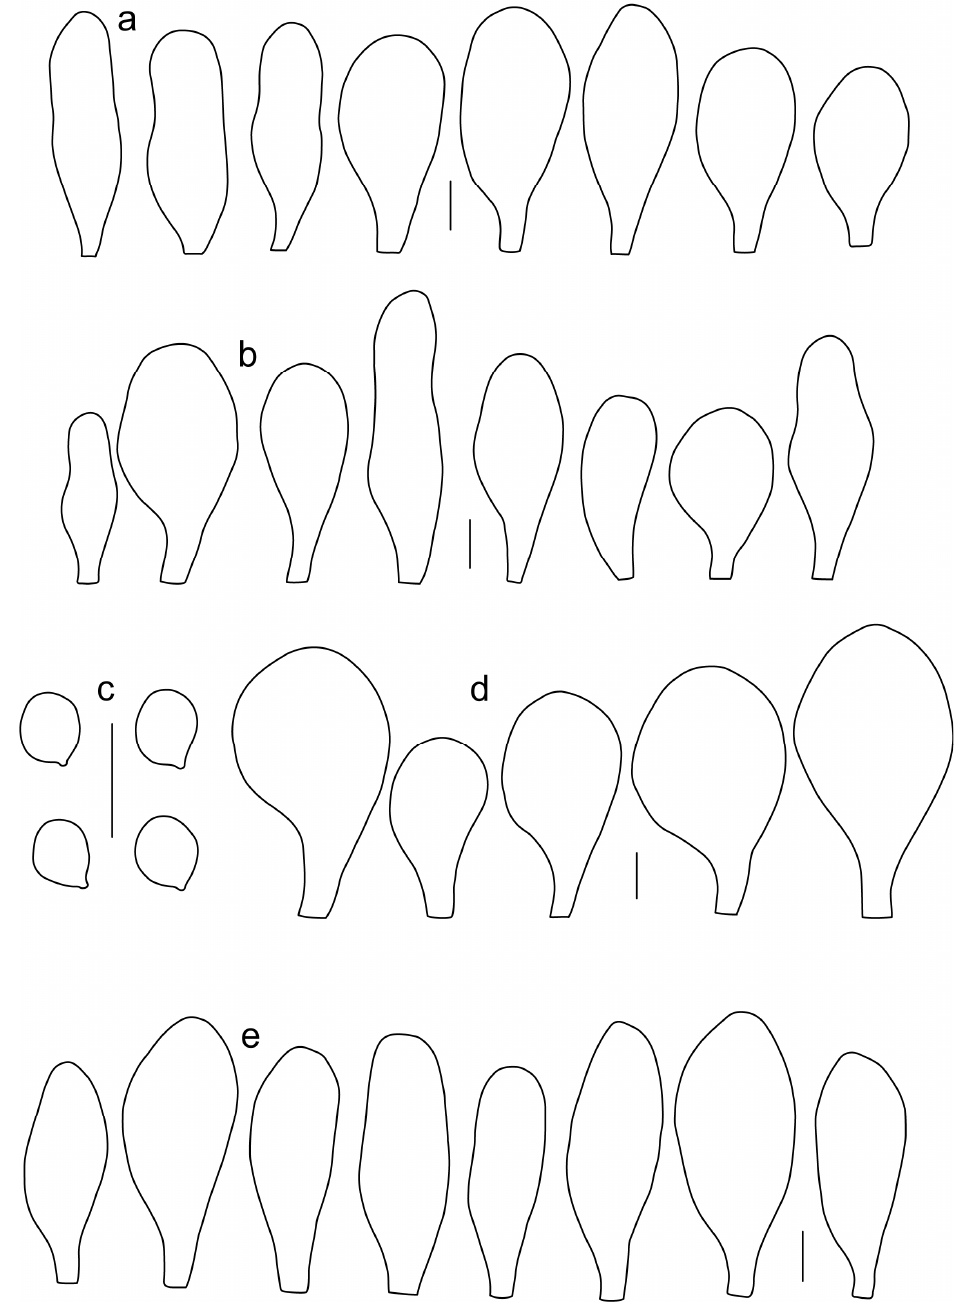
Figure 15. Pluteus vellingae : ( a ). pleurocystidia, ( b ). cheilocystidia ( c ). basidiospores, ( d ). pileipellis elements, ( e ). caulocystidia. Scale bars 10 µm.